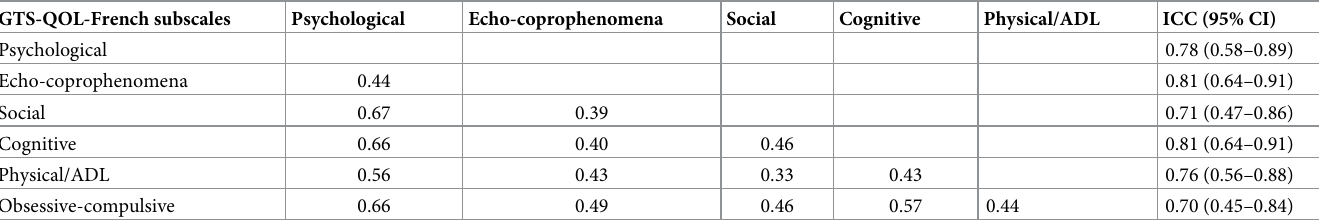
Table 6. Inter-subscale correlations and test-reliability for the GTS-QOL-French subscales. GTS-QOL-French